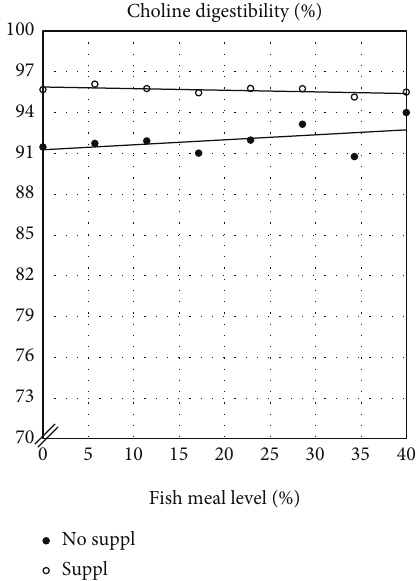
Figure 4: Estimated digestibility of choline in FM and in the choline supplement (estimated by di ff erence). E ff ect of dietary fi shmeal level and supplementation (No suppl vs. Suppl) with a mixture of 0.3% choline chloride, 0.05% β -glucan, and 0.05% nucleotides on digestibility of choline. The statistical evaluation showed no signi fi cant e ff ect of dietary fi shmeal levels. For the unsupplemented diet series, the results were as follows: p ð model Þ = 0 : 2359 ; R 2 = 0 : 22 ; Intercept = 91 : 3 ; Reg coeff = 0 : 037 , and for the supplemented diet series: p ð model Þ = 0 : 118 ; R 2 = 0 : 36